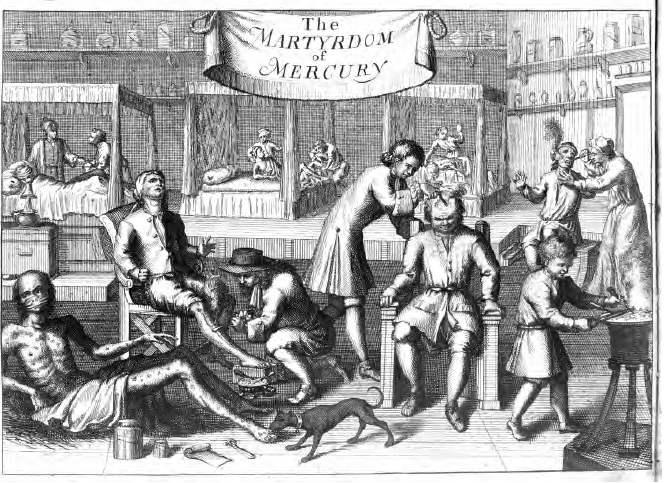
Figure 1. The Martyrdom of Mercury. The scourge of Venus and Mercury, represented in a treatise of the venereal disease. John Sintelaer. 1709. London: G.